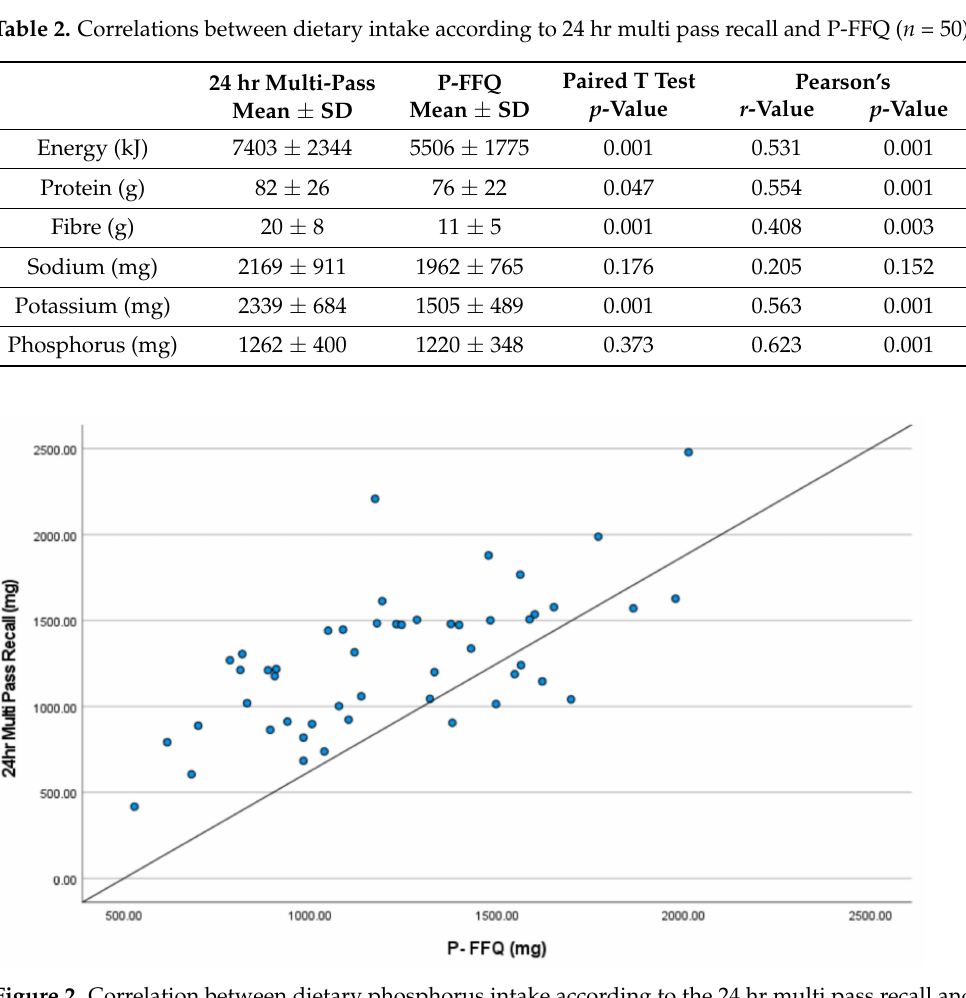
Figure 2. Correlation between dietary phosphorus intake according to the 24 hr multi pass recall and